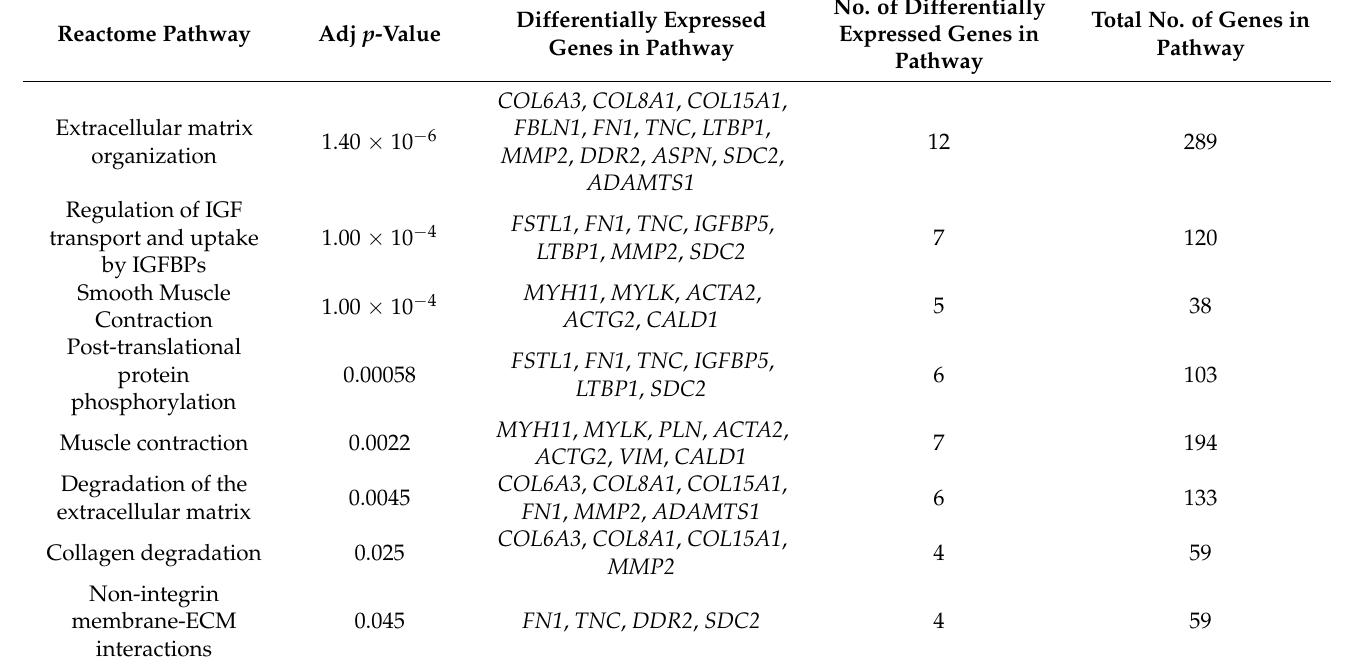
Table 2. Reactome pathways significantly enriched (Benjamini–Hochberg-adjusted p -value < 0.05) within a list of 35 AKT3 -associated genes. Shown from left to right are Reactome pathway name, Benjamini–Hochberg-adjusted p -value, symbols for genes differentially expressed in the dataset by pathway, the number of genes differentially expressed in the dataset by pathway and the total number of genes within the Reactome database for each